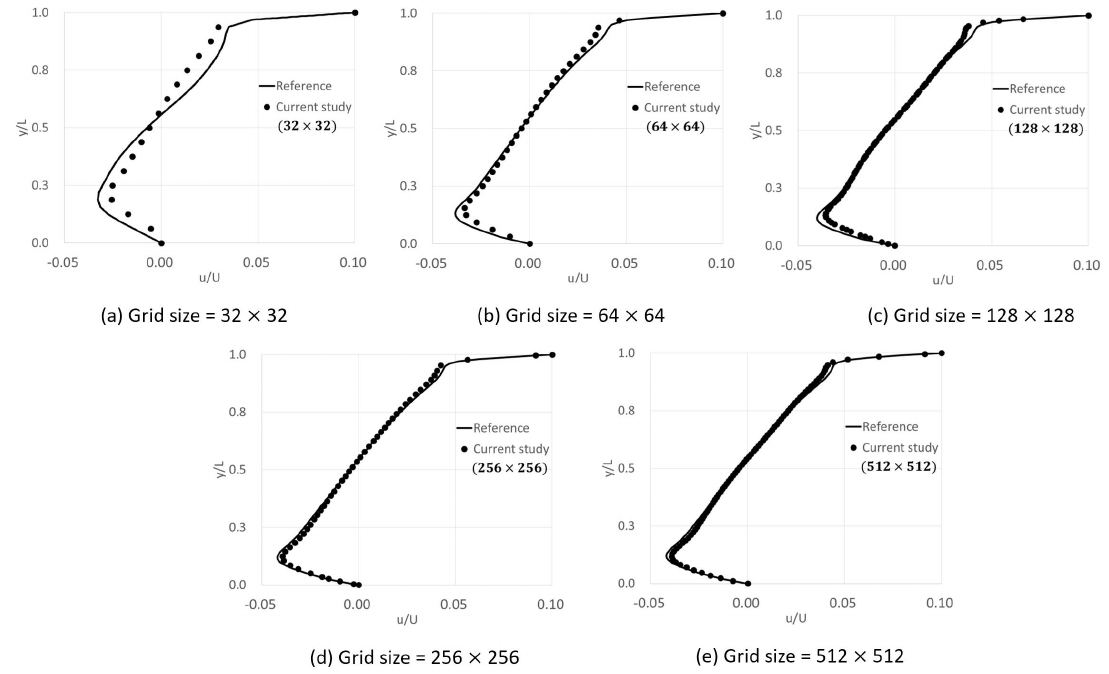
Figure 6. Vertical distribution of horizontal velocities with various mesh